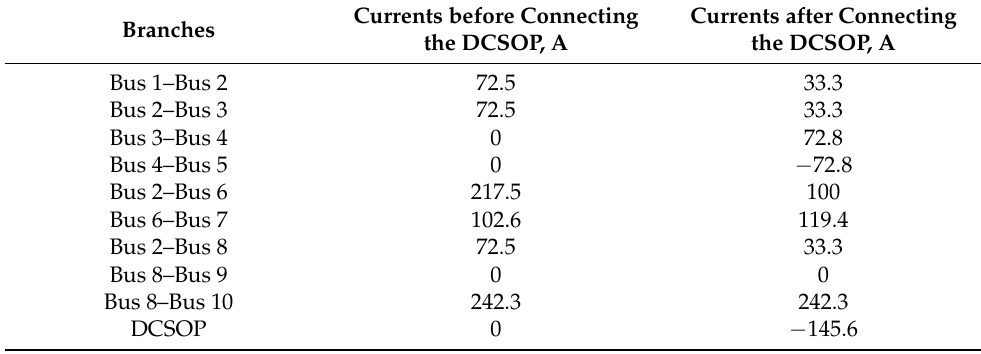
Figure 17. Currents from the DC microgrid generators before/after connecting the DCSOP. Table 2. Currents through the DC microgrid feeders before/after connecting the DCSOP.